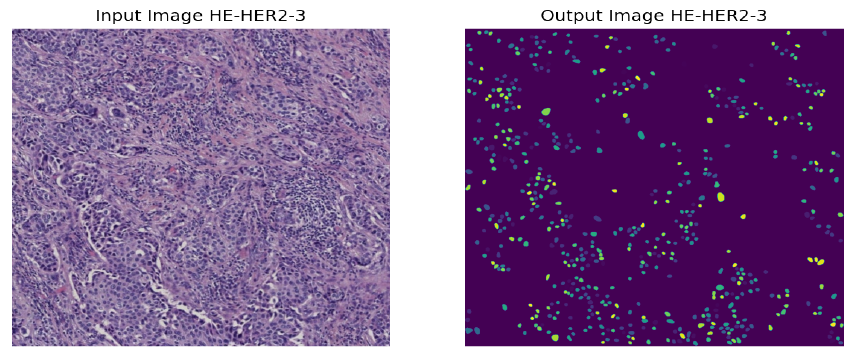
Figure 14. Nuclei segmentation of HER2-3+ Breast